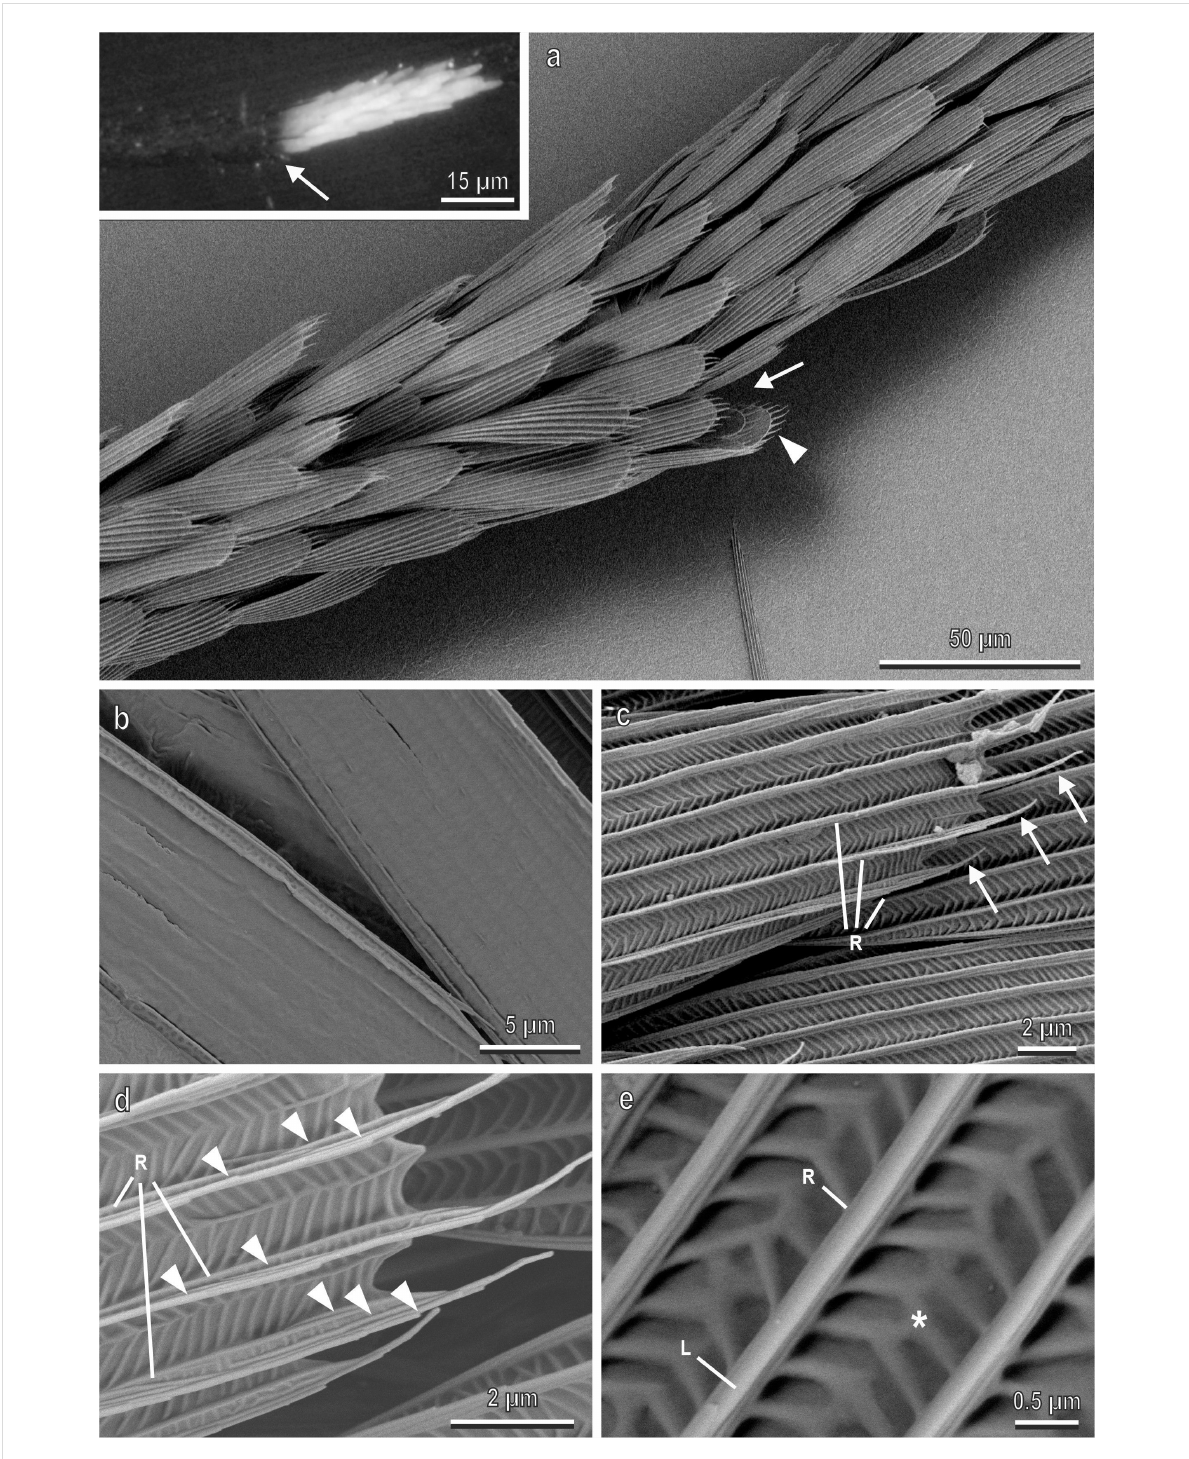
Figure 3: Tarsal black and white scales of Aedes albopictus (female) in a cryo-SEM. (a) Scales at the articulation (arrow) between the tarsal seg- ments of the hindlegs, where the black scales are close to the white scales (in the inset the same image under stereomicroscope is shown). Note that both scales are spatulate, convex and show a rounded apex. Their size is variable, and some small scales are visible under wider scales (arrow head). (b) The lower surface of two scales without special micro- or nanostructures. (c) Upper surface of the scale with numerous longitudinal ridges (R) extending beyond the apical portion of the scale thus forming an apical fringe (arrows). (d) Detail of the longitudinal ridges (R) constituted of overlapping cuticular folds generating microribs (arrow heads) along the sides of the ridges. (e) Cuticle between longitudinal ridges (R) decorated with anisotropically situated nanostructures with a herringborne pattern (asterisk). L,